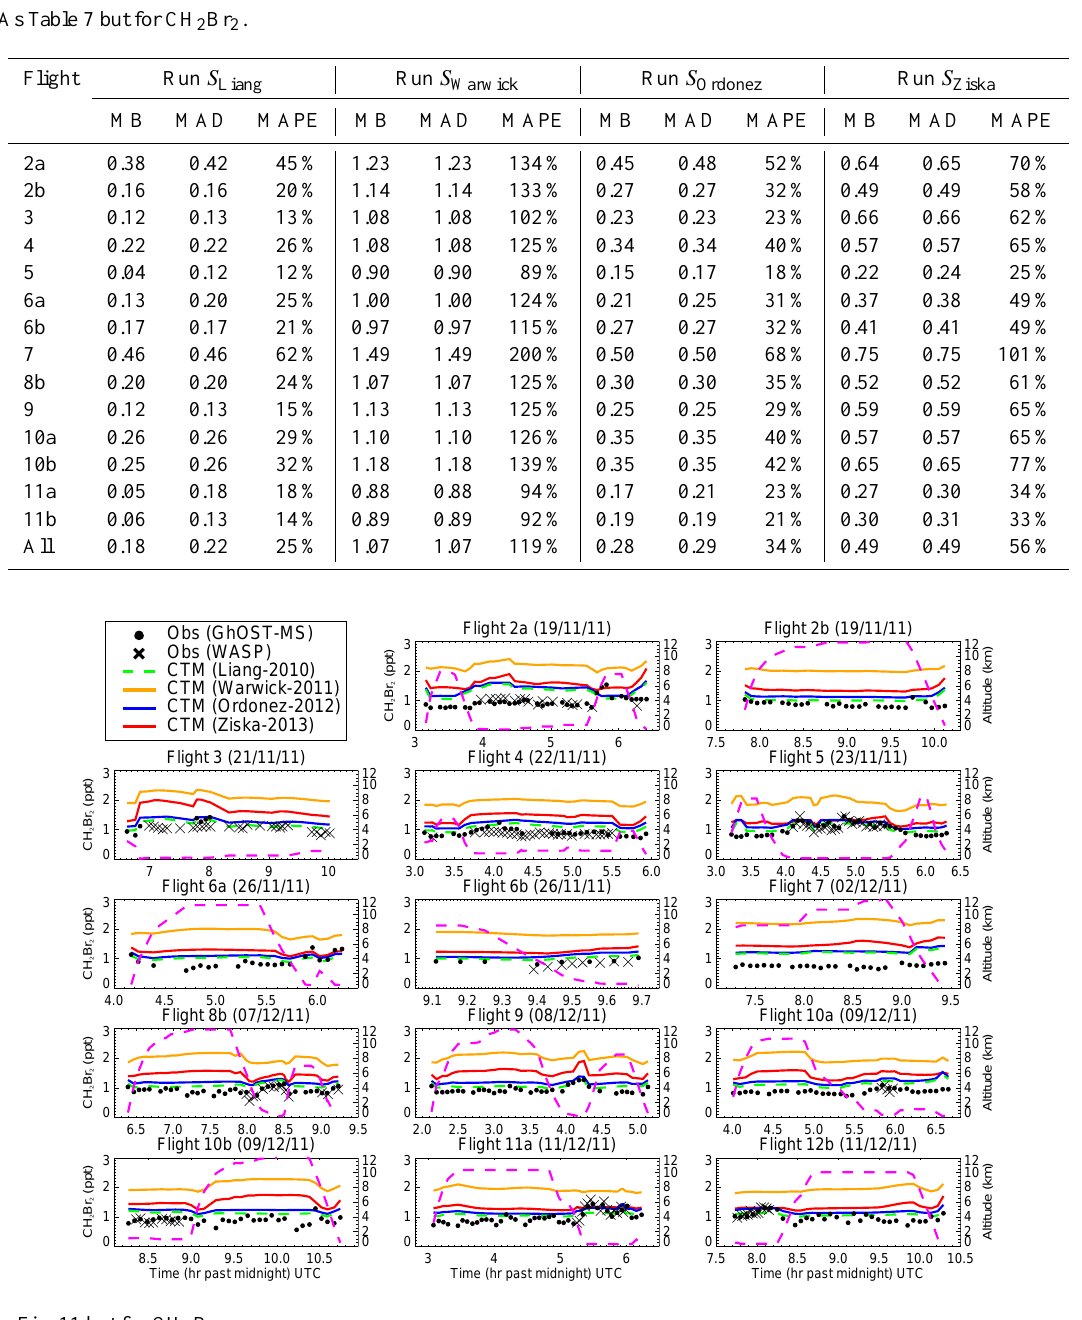
Fig. 12. As Fig. 11 but for CH 2 Br 2